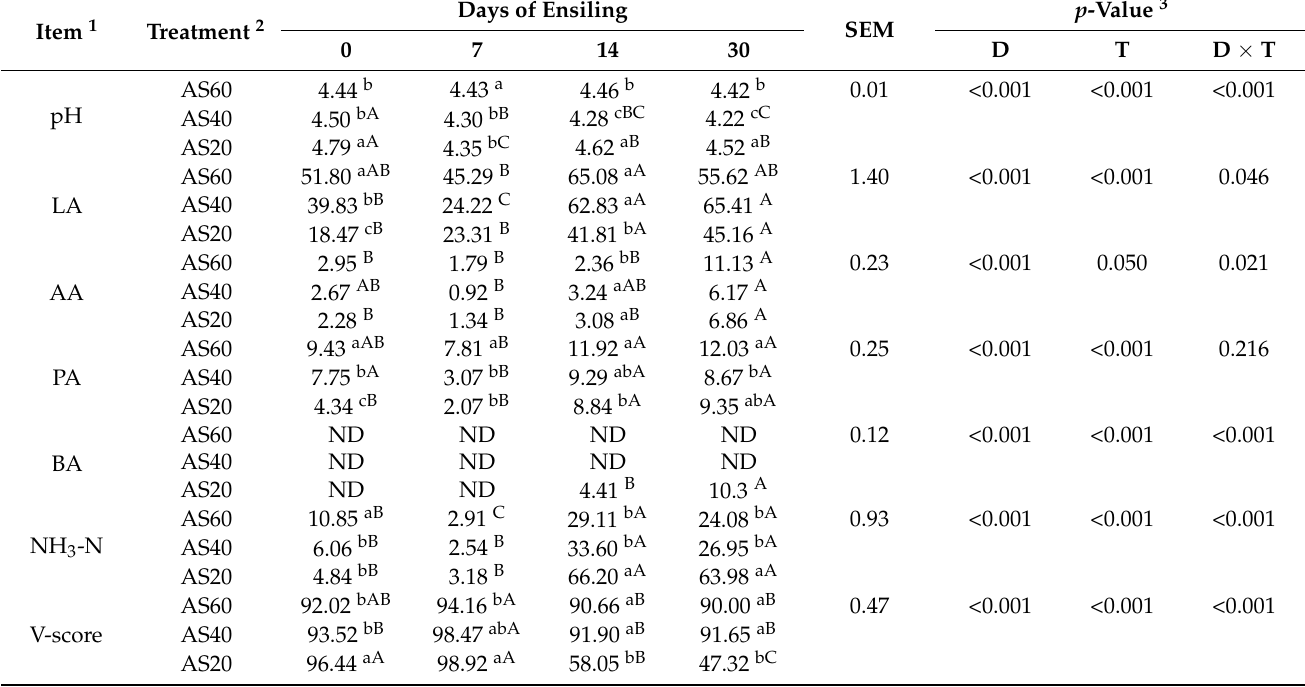
Table 3. Changes in fermentative characteristics during ensiling of the TMR silages.